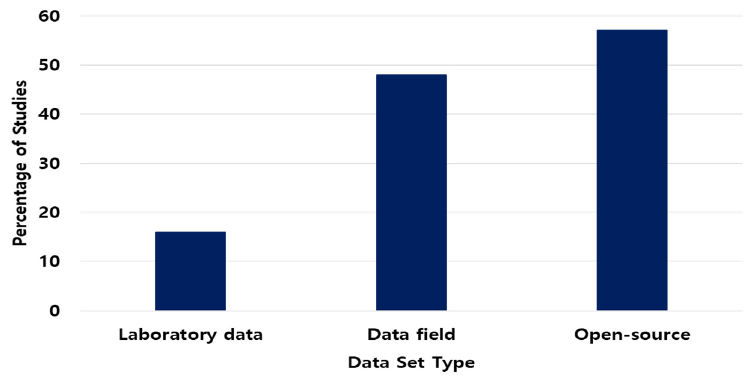
Figure 6. Data set type.